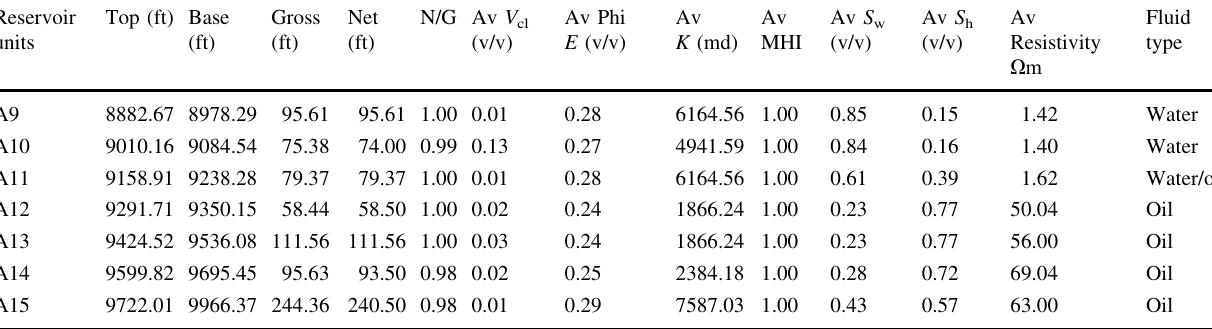
Table 5 Average petrophysical parameters for the reservoirs in JAP-4 well Reservoir